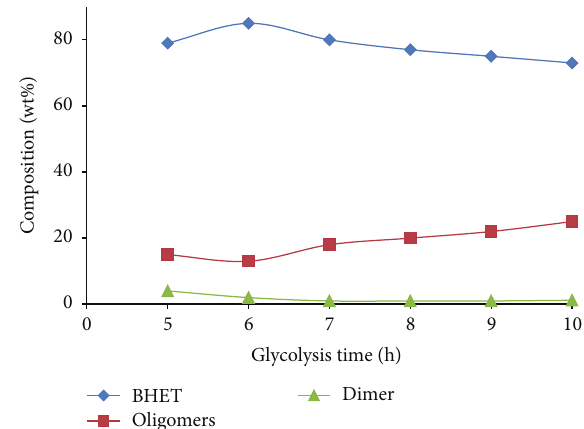
Figure 5: Effect of glycolysis time on distribution of the products (1atm, 180 ∘ C, with 4.0 gr of [bmim] Br) [9].